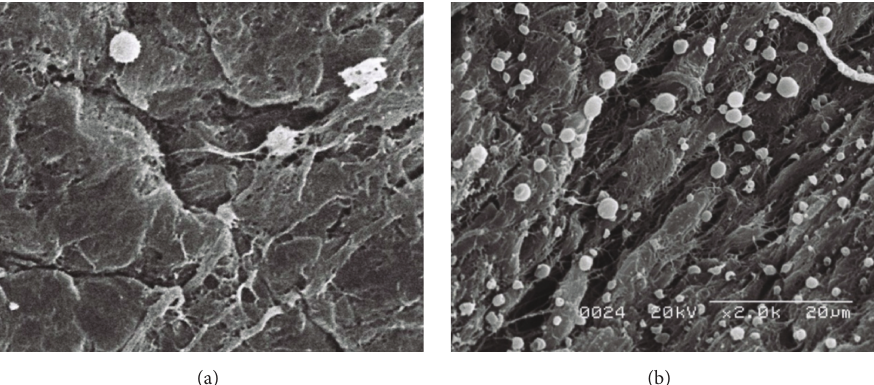
Figure 10: There were numerous granules in the left eye of Rabbit Number Four, which was treated with 1.00% ICG (b). In contrast, very few remnant ICG particles were observed in the right 0.25% ICG-treated eye of this rabbit